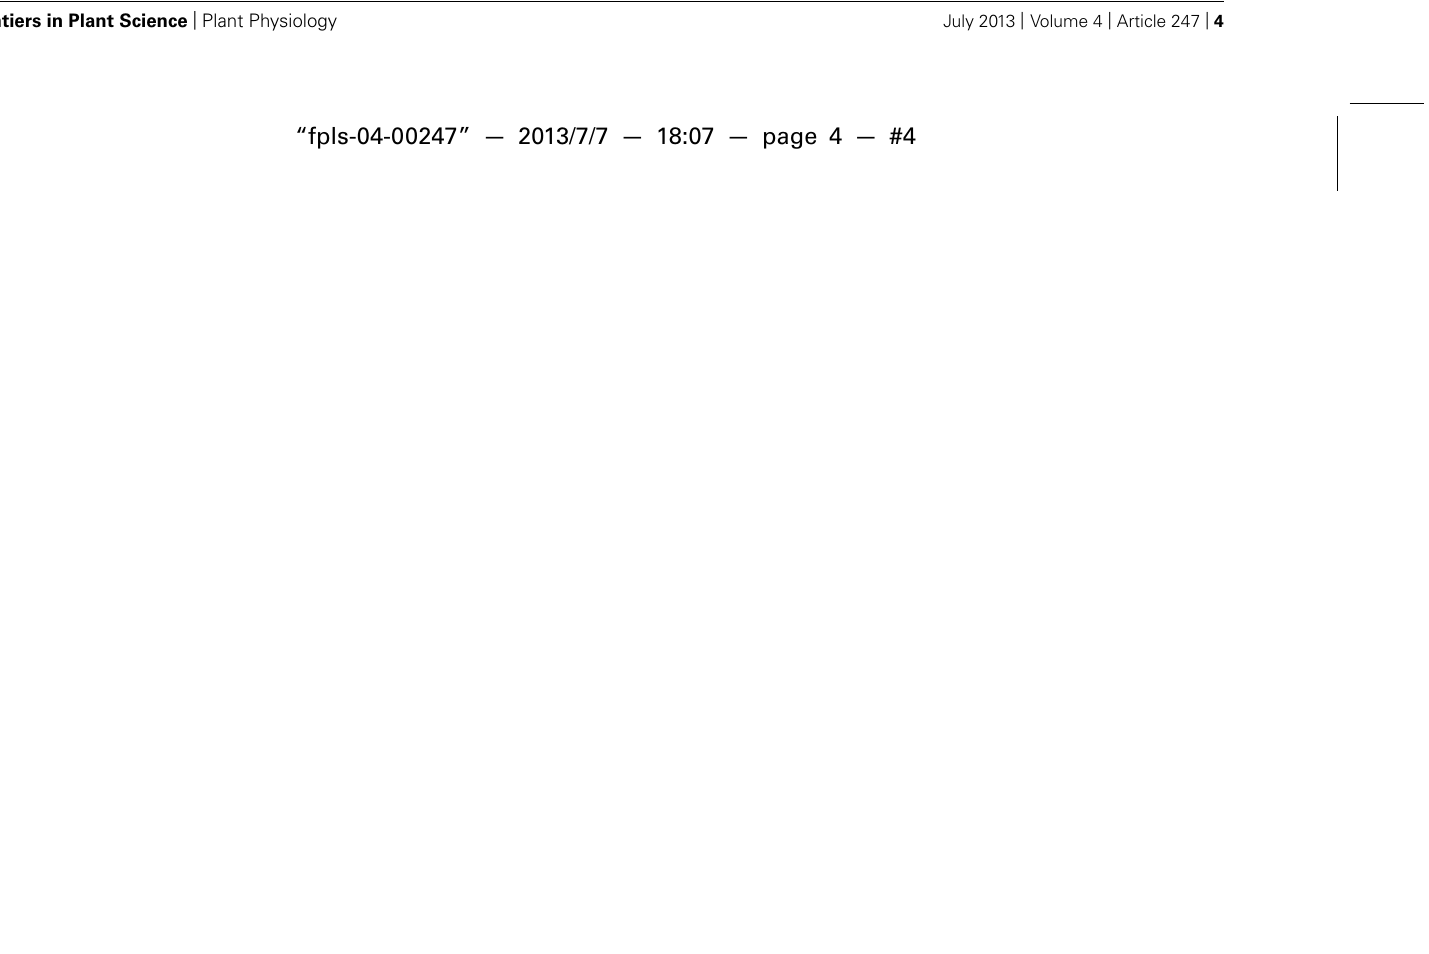
accumulators (chicory, wheat, ryegrass, onion, Agave, and Pachysandra) is drawn to illustrate the polyphyletic origin of fructan biosynthesis in higher